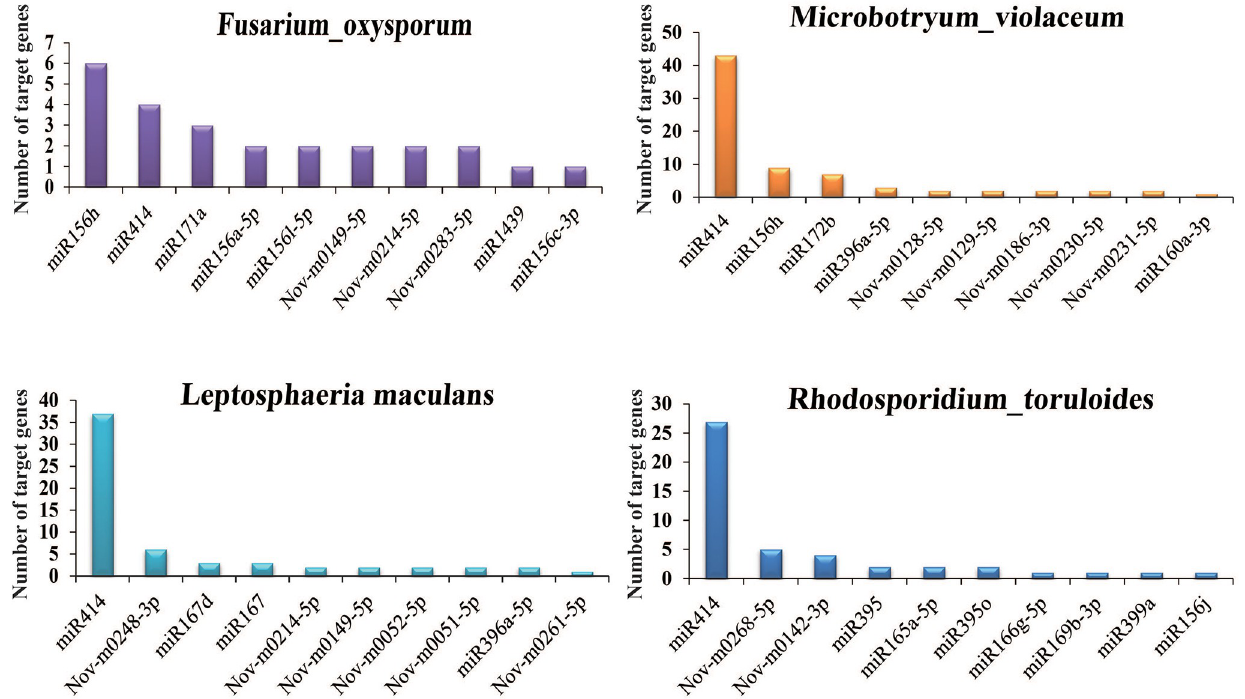
Fig 10. Number of genes from pathogens targeted by miRNAs from P . heterophylla .